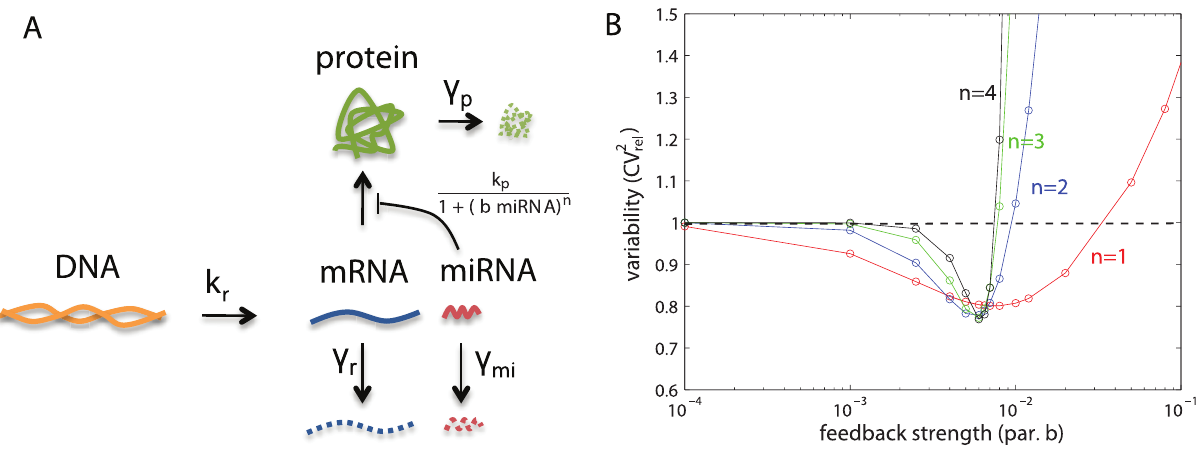
Figure 10. Results for post-transcriptional self-repression modeled by a Hill function. (A) Single gene expression model with post- transcriptional self-repression modeled by a Hill function. (B) Effect of self-repression on variability with only intrinsic sources of variability, for Hill coefficient values of 1, ... ,4 .